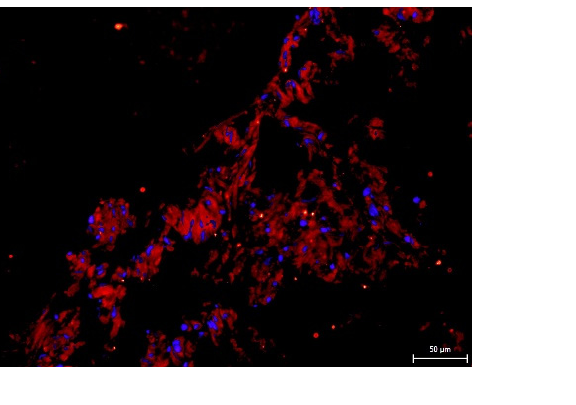
( b ) Figure 8. Histological visualization of collagen and procollagen in an extracellular matrix of paired DPSC lineages after chondrogenesis. After histological staining using blue Masson’s trichrome, the collagen and procollagen appear as blue areas. Scale bar 50 μ m. ( a ) Lineage 5-A; ( b ) Lineaage 5-B. ( a ) ( b ) Figure 9. Immunocytochemical visualization of osteocalcin in the extracellular matrix of paired DPSC lineages after osteogenesis. Osteocalcin is revealed as brown areas. Scale bar 50 μ m. ( a ) Lineage 5-A; ( b ) Lineage 5-B.